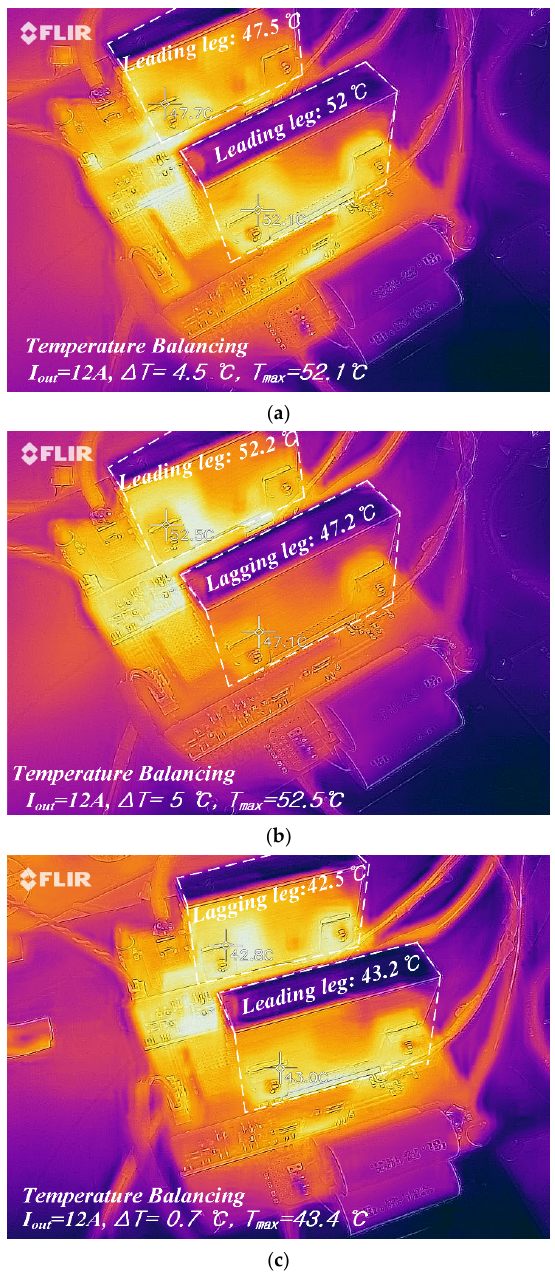
Figure 12. Experimental waveforms from the proposed temperature balancing. ( a ) The leading leg is S 1 and S 2 , and the lagging leg is S 3 and S 4 . ( b ) The leading leg is S 3 and S 4 , and the lagging leg is S 1 and S 2 . ( c ) Temperature balancing between the legs.